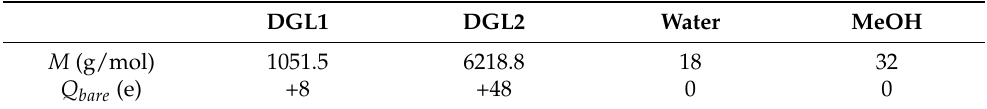
Table 2. The characteristics: the molecular mass M and the bare charge Q bare of dendrigrafts DGL1 and DGL2, one molecule of water and methanol (MeOH).